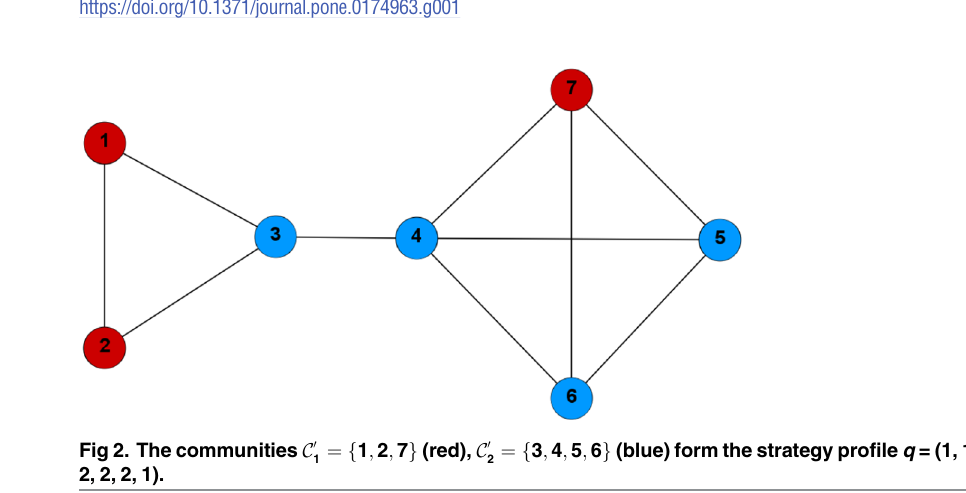
Fig 1. The communities C 2, 2, 2, 2).